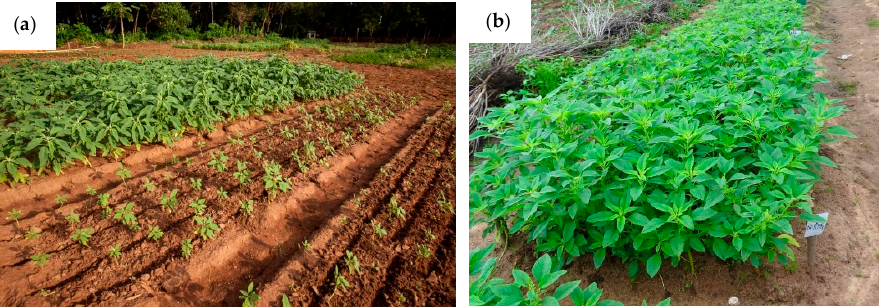
Figure 1. Photo of Amaranthus cruentus and Solanum macrocarpon growing in ( a ) Ilesha and ( b ) Ina.